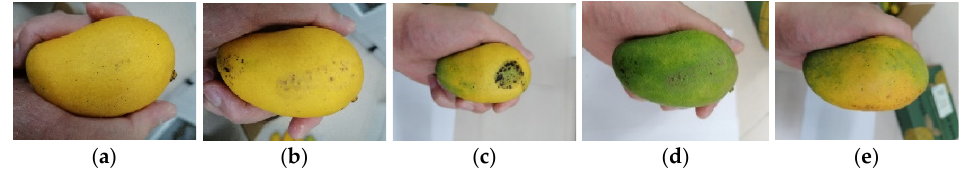
Figure 1. Different levels of mango samples. Level A has almost no defects and its greenness is less than 20%; Level B’s defects are less than 10%; Level C’s defects are more than 10%; Level D has almost no defects and its greenness is more than 70%; Level E has almost no defects and its greenness is between 20~70%. ( a ) Level A; ( b ) Level B; ( c ) Level C; ( d ) Level D; ( e ) Level E.